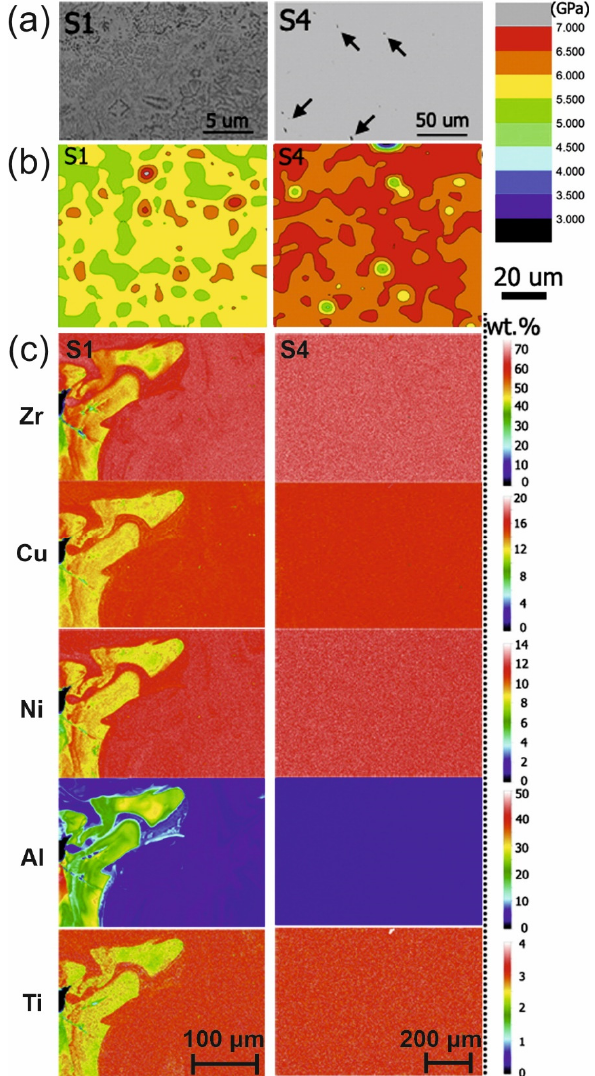
Figure 23. ( a ) Back-scattered electron (BSE) images of a Zr-based BMG fabricated with two sets of parameters, S1 and S4, ( b ) nanohardness maps of the two samples, and ( c ) electron probe microanalyzer (EPMA) maps of the two samples. Modified from [85], with permission from Elsevier, 2021.